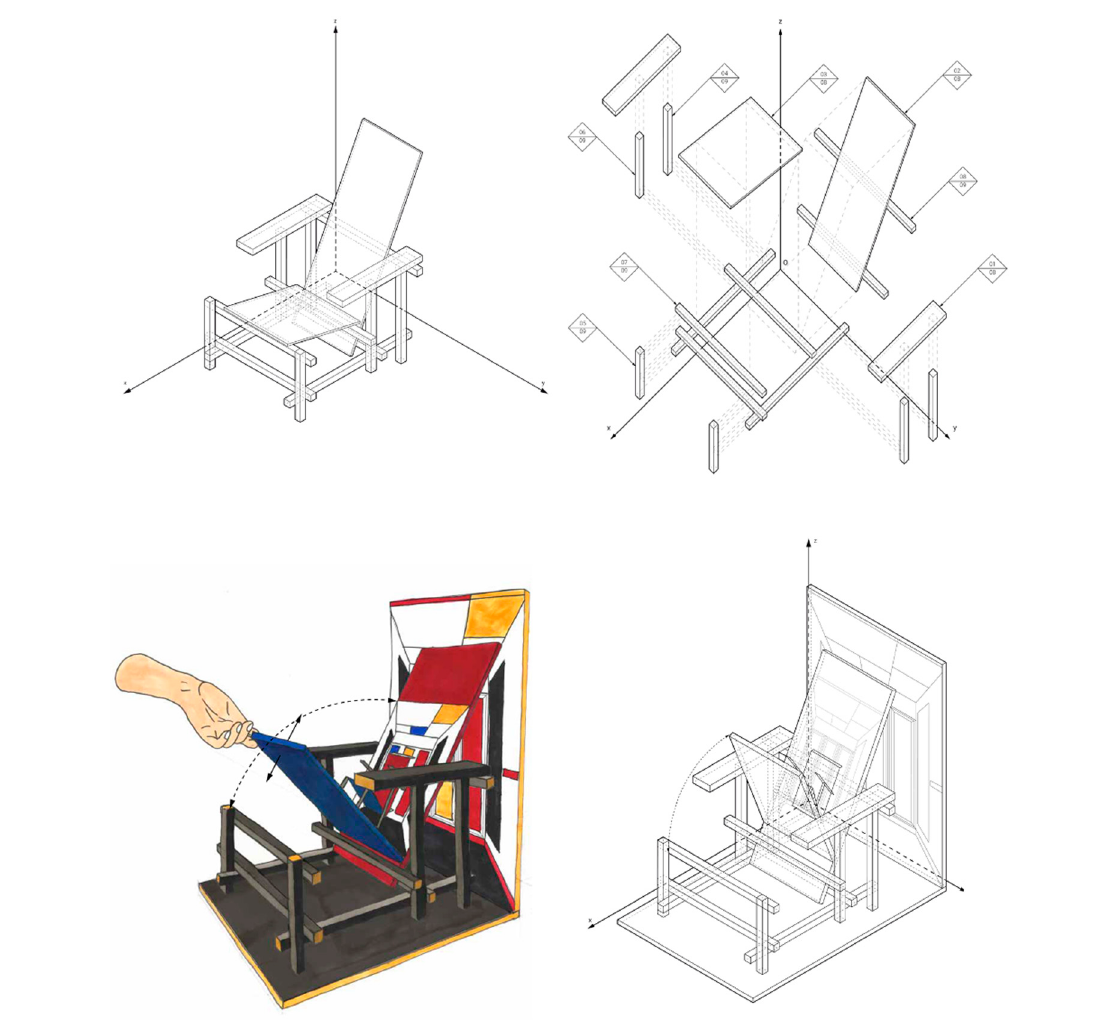
Figure 4. Survey and redrawing process of a chair and its components. After this step the students had to develop a sketch of the intended metamorphosis and then technical drawings related to the